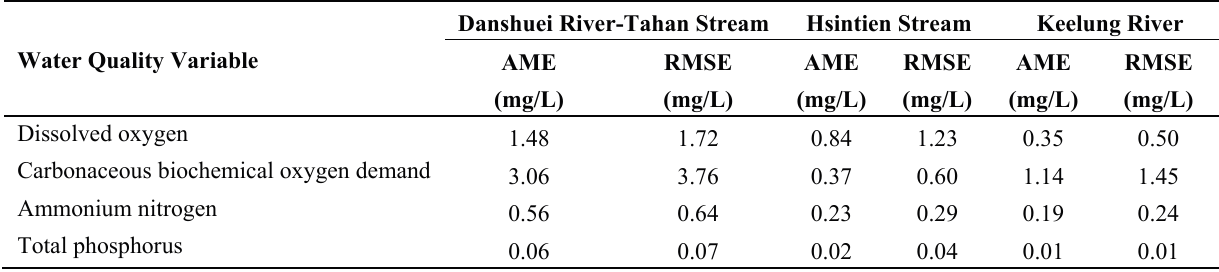
Table 3. Statistical error between simulated and measured water quality variables on 1 March 2010. Water Quality Variable